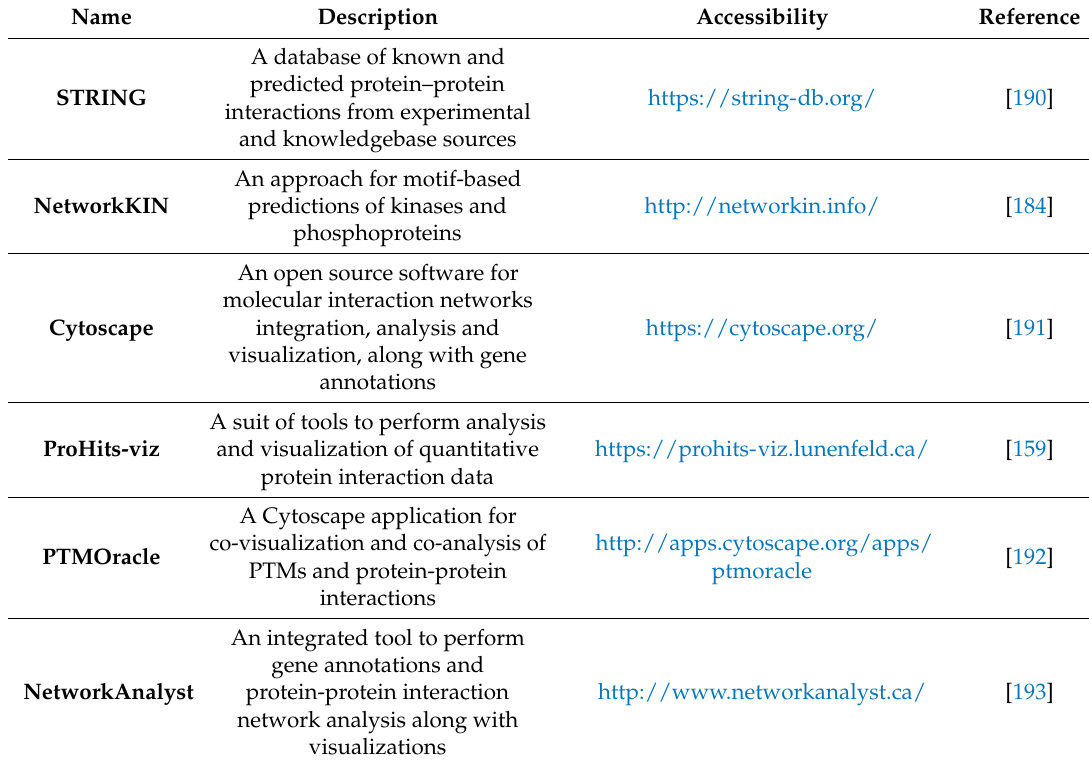
Table 4. Tools for protein interaction analyses that can also be useful in PTM